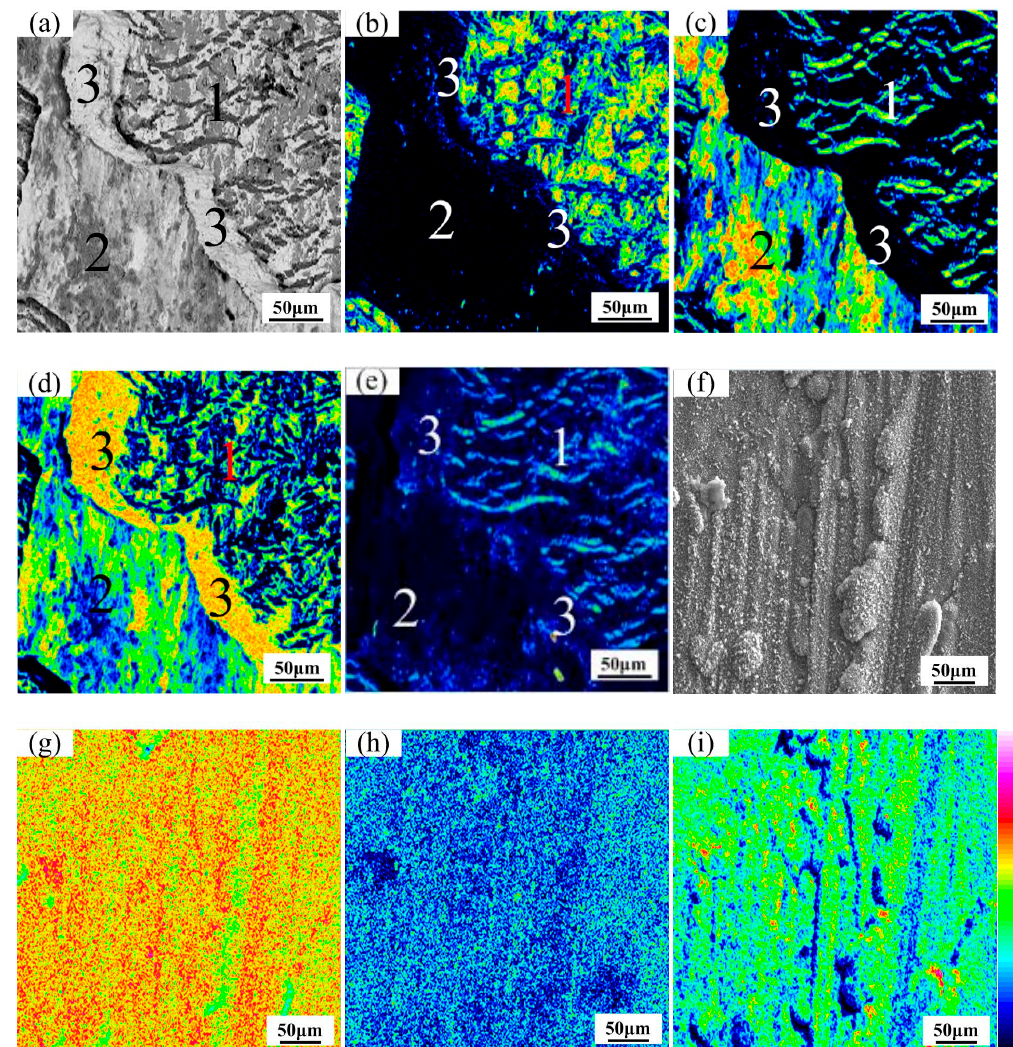
Figure 10. Map distribution micrographs of various elements on the fractural surface at 1000 °C (titanium side): ( a ) BSE image; ( b ) Fe element; ( c ) Ti element; ( d ) Nb element and ( e ) C element for Ti/Nb/steel clad plate; ( f ) BSE image; ( g ) Fe element; ( h ) Ti element and ( i ) C element for Ti/steel clad plate.